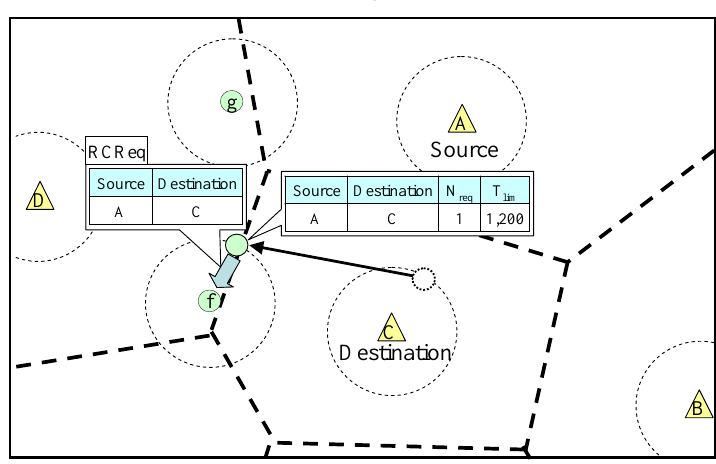
Figure 5. (c) Sending RCReq to connected mobile